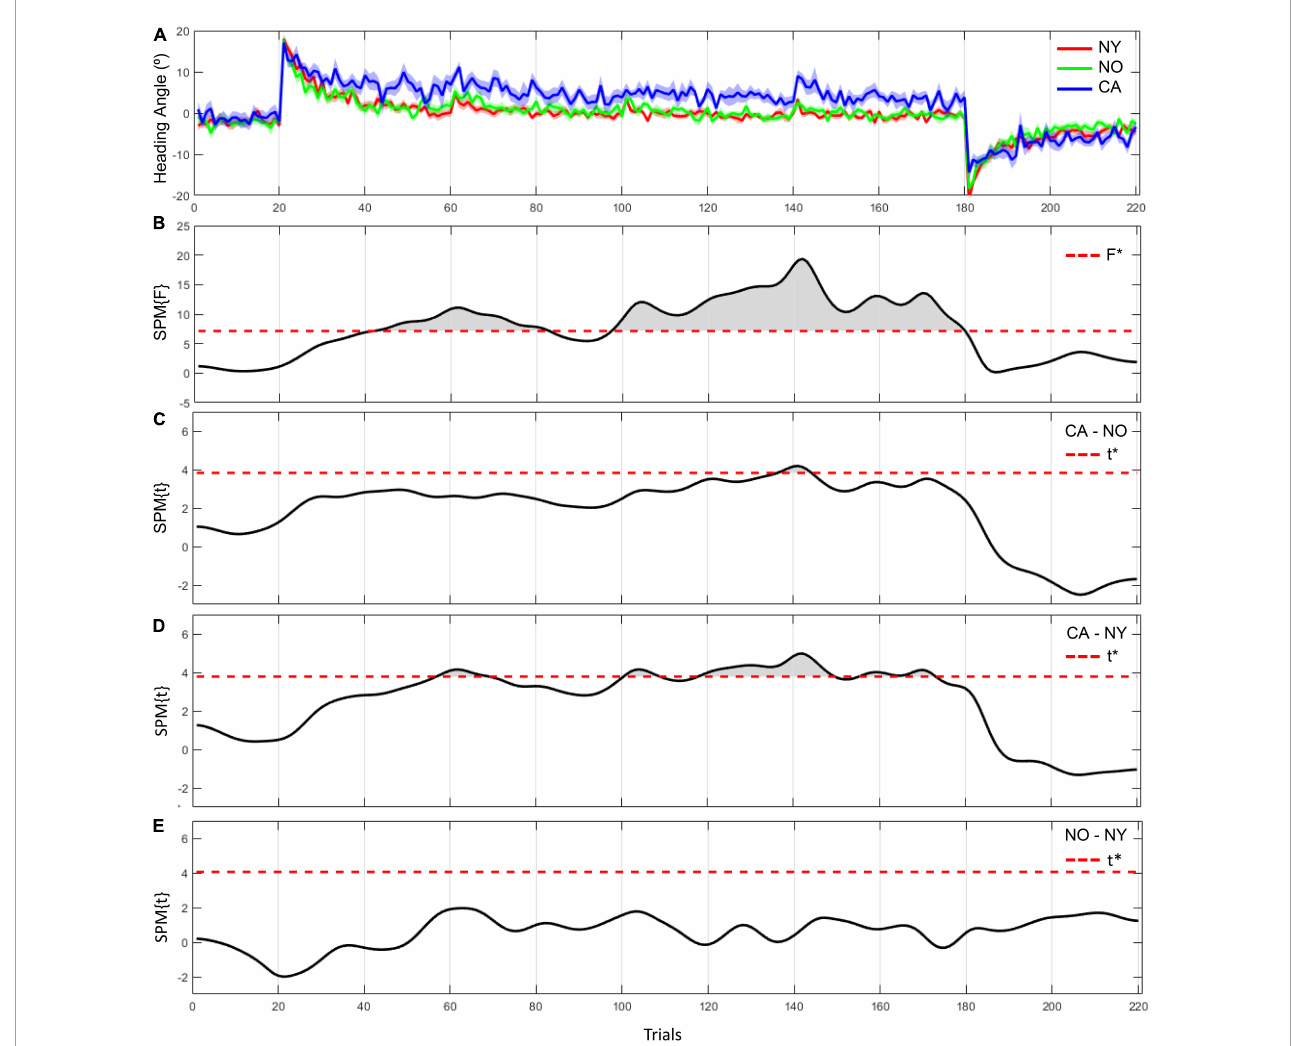
FIGURE4 The heading angle error between the three groups and the results of statistical inference. (A) The red line and its shaded area represent the averaged heading angle error and standard error of mean in NY group. The green and blue lines and shaded areas represent the same in NO and CA groups, respectively. (B–E) F-scores in one-way ANOVA and t-scores in two-sample t -test as a post hoc paired comparison. F star (*) and t star (*) represent a significance threshold in each analysis.